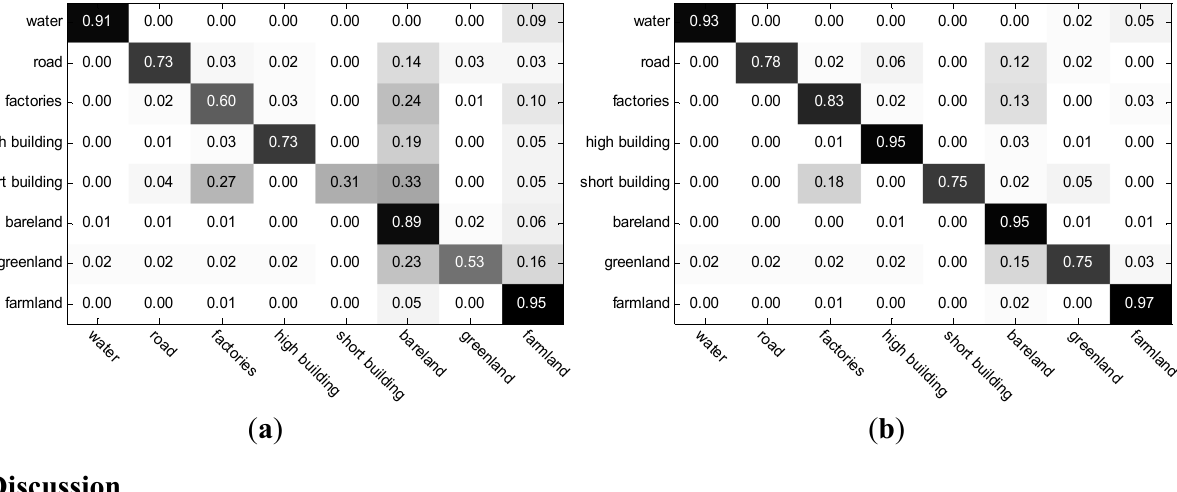
Figure 12. Confusion matrix of semantic classes obtained by MedLDA and our proposed method. ( a ) MedLDA. ( b ) M 3